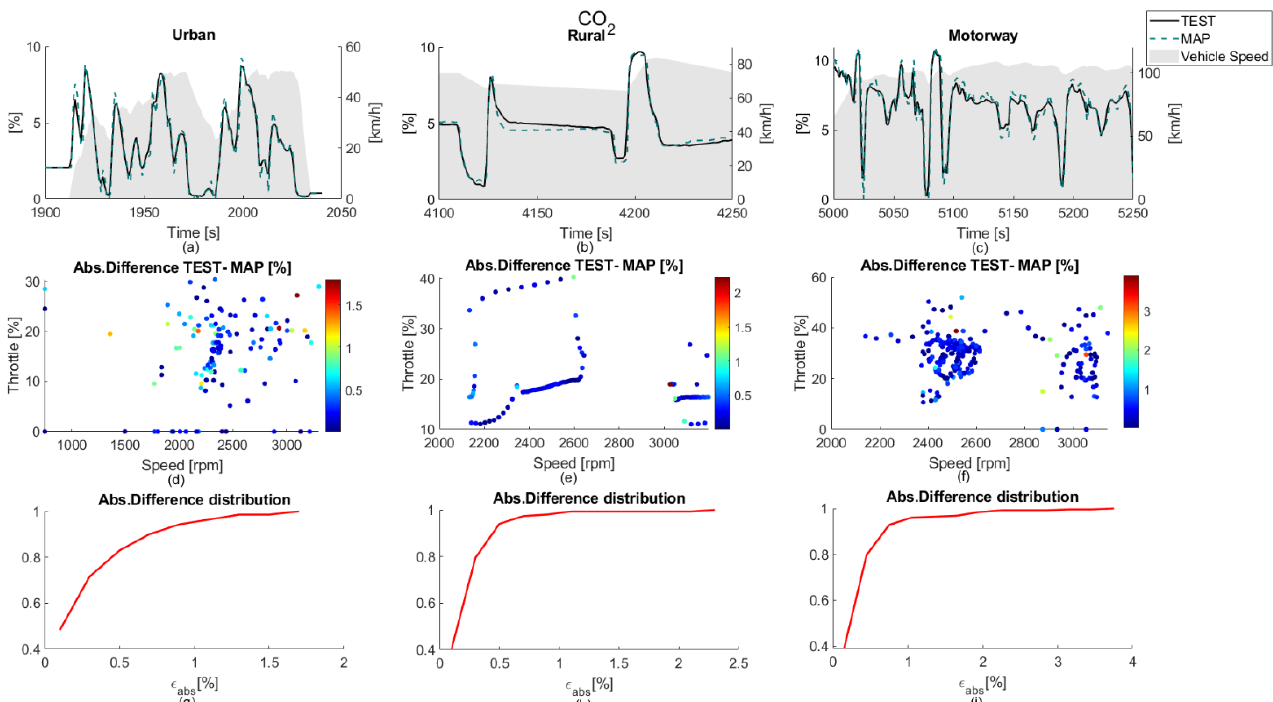
Figure 13. CO 2 emissions comparison between RDE 1 and engine map in urban ( a,d,g ), rural ( b , e , h ), and motorway ( c , f , i ) driving phases.